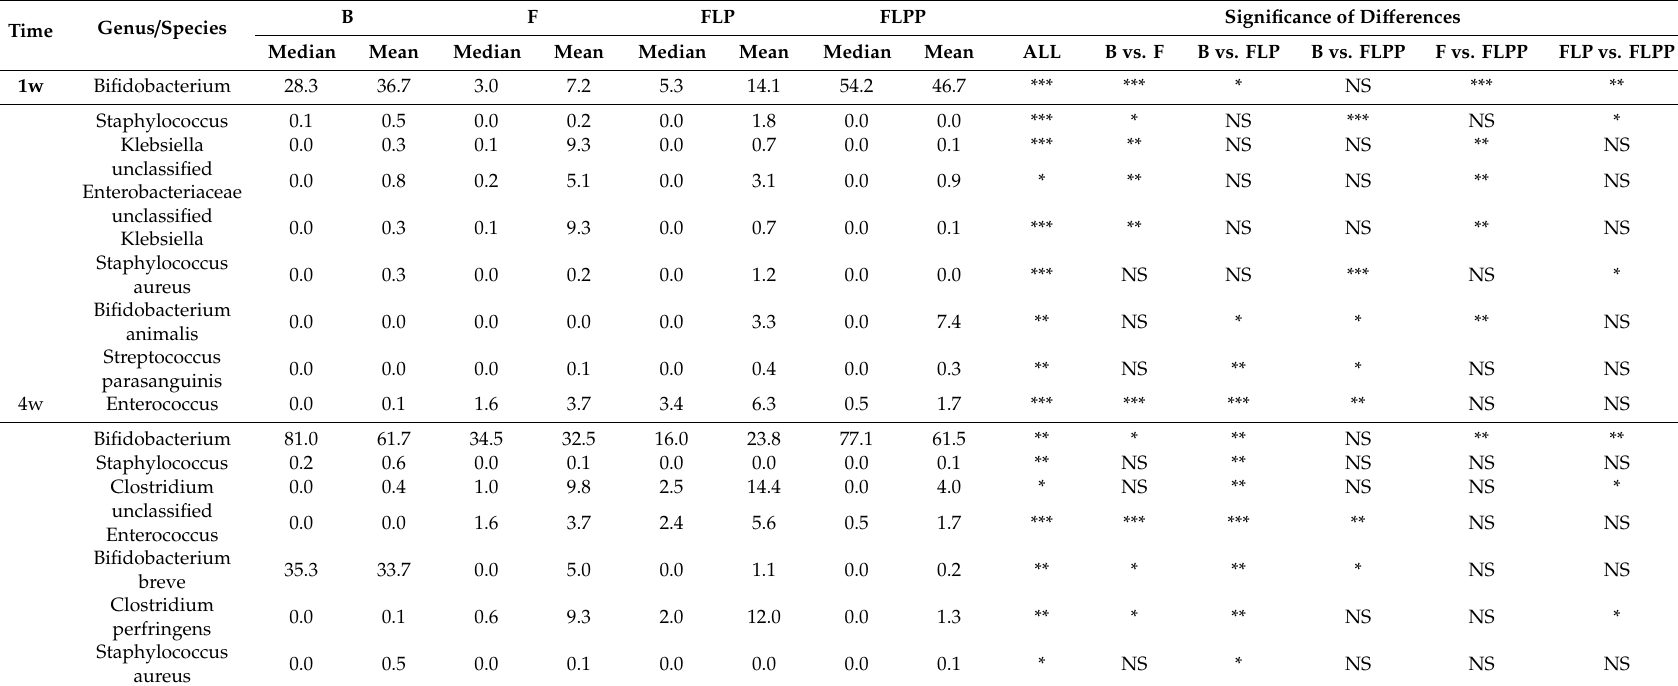
Table 4. Statistical analyses of the di ff erences of median between groups at genus and species